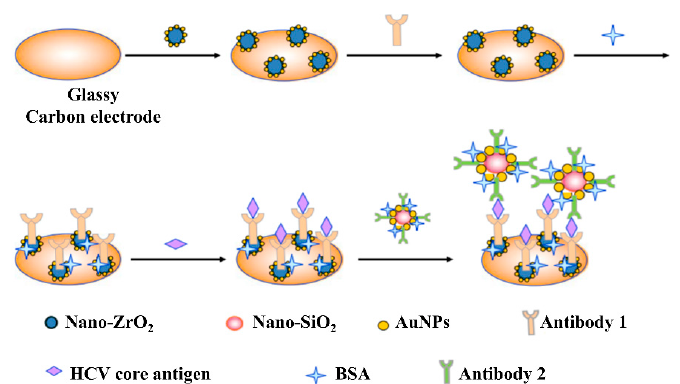
Figure 9. Schematic illustration of the electrochemical immunosensor construction process and its application in the detection of HCV core antigen [115].